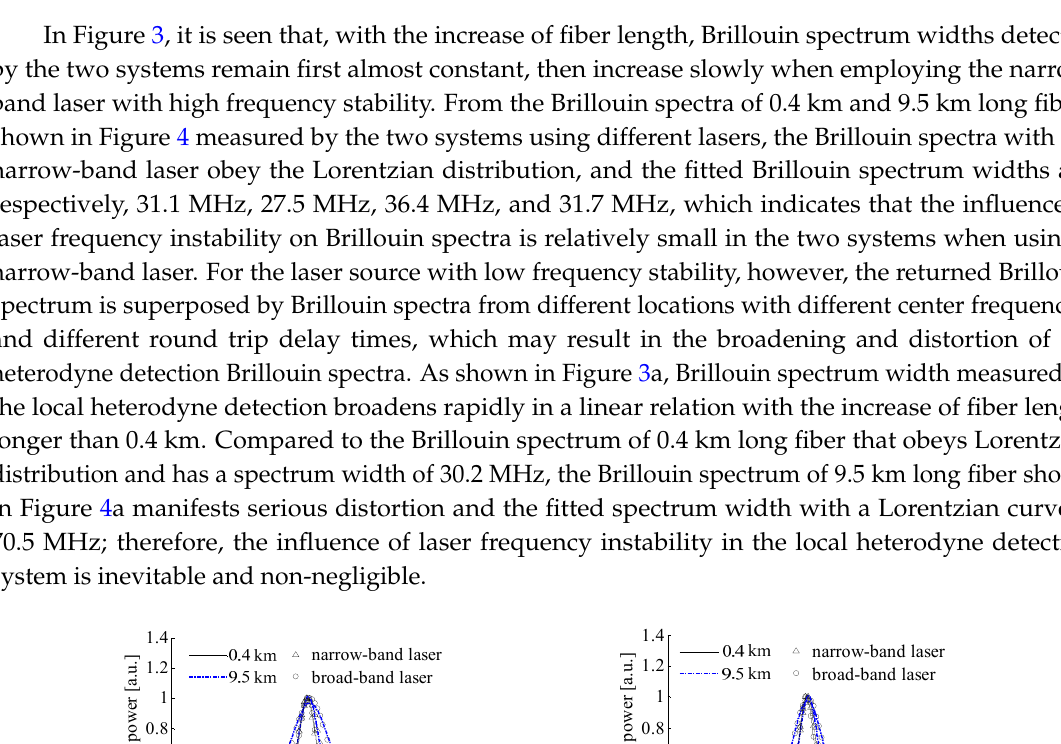
Table 1. Fiber lengths used in Brillouin spectrum measurement.